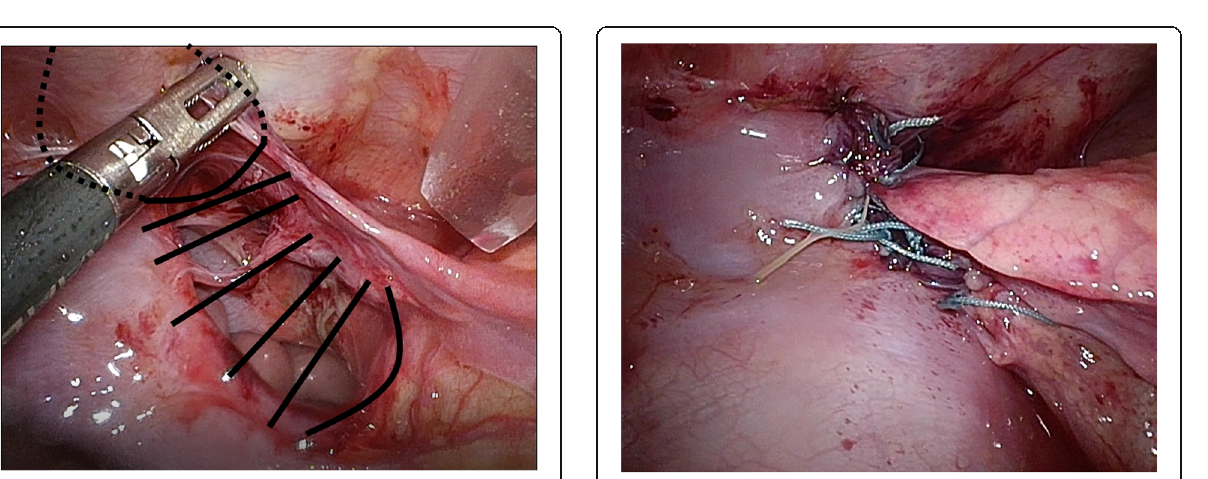
Fig. 6 Closure of the diaphragmatic defect. Using seven